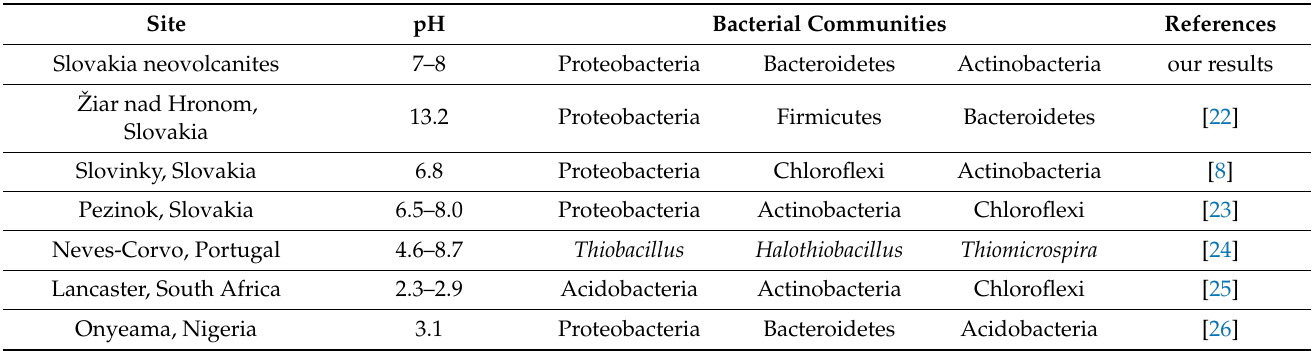
Table 4. Comparison of microbial communities in mine drainage at different